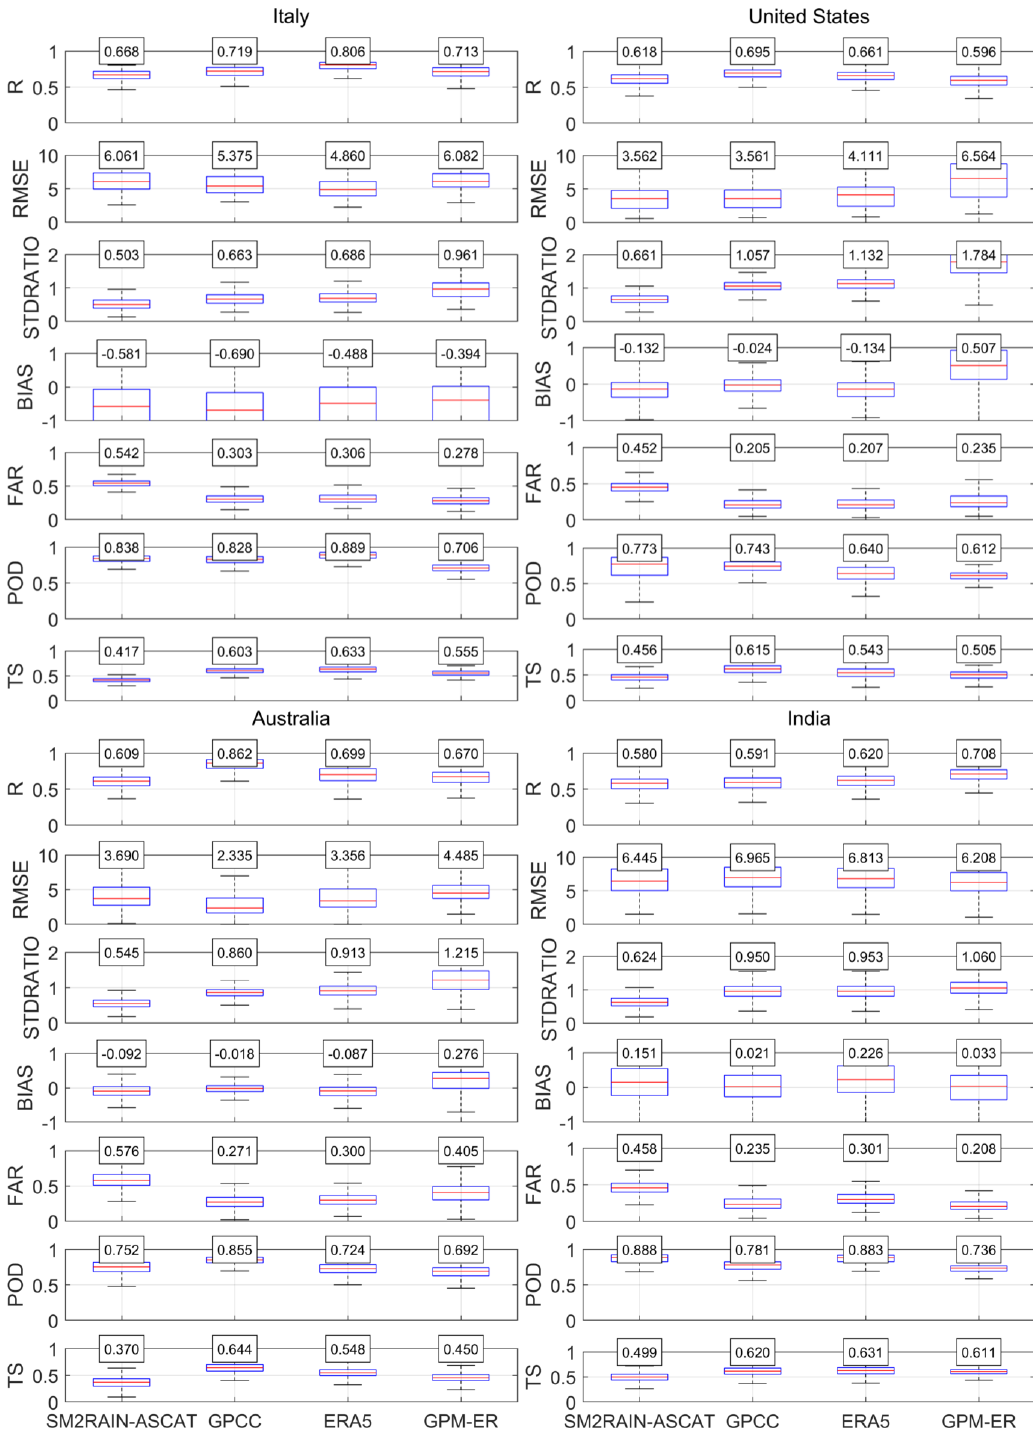
Figure 6. Regional assessment of the SM2RAIN–ASCAT rainfall data record and comparison with GPCC, ERA5 and GPM-ER rainfall products. As a reference the high-quality ground-based datasets in Italy, the United States, India, and Australia are used. Results in terms of Pearson’s correlation, R (–), root mean square error, RMSE (mmd − 1 ), the variability ratio, STDRATIO (–), the mean error between estimated and reference rainfall, BIAS (mmd − 1 ), the false alarm ratio, FAR (–), the probability of detection, POD (–), and the threat score, TS